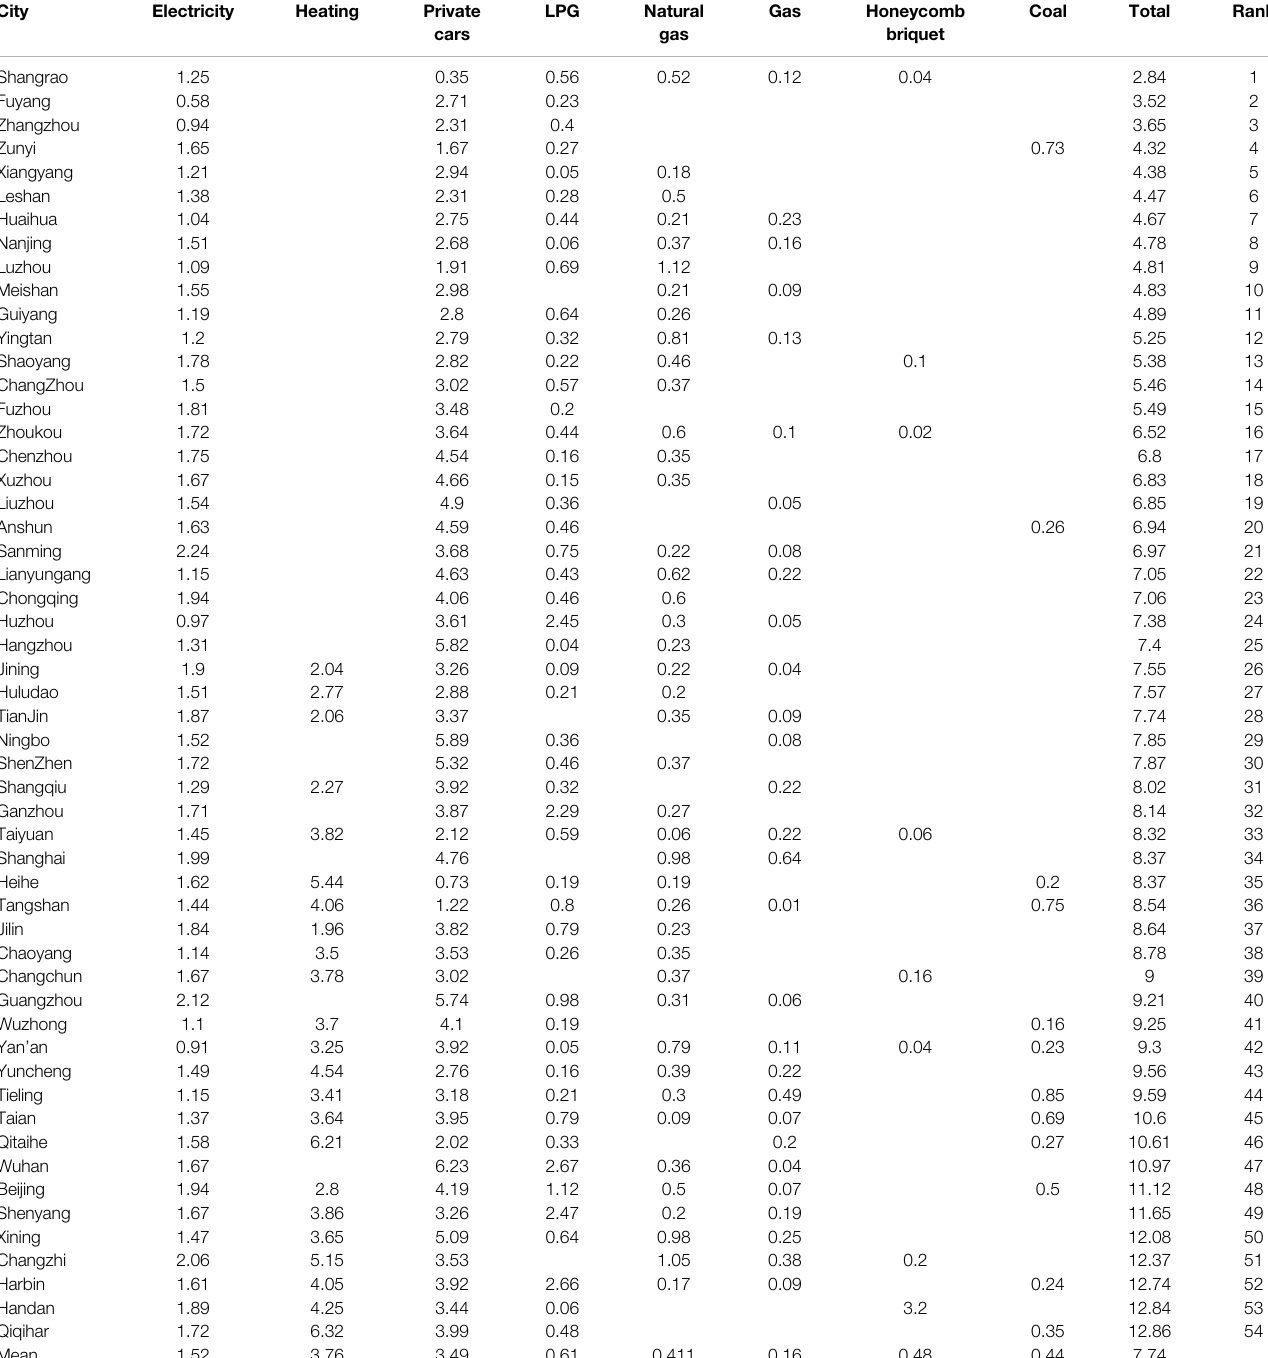
TABLE 4 | Urban household carbon emission ranking in 2014. City Electricity Heating Private